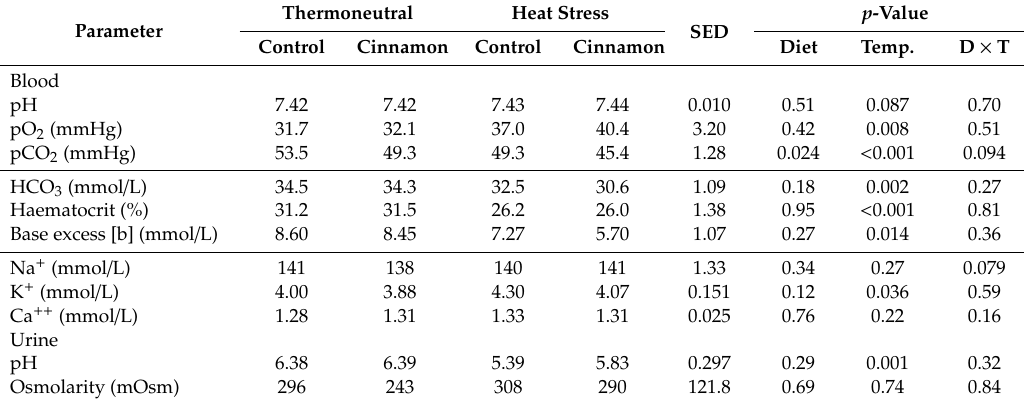
Table 4. The e ff ect of dietary cinnamon (control vs. 1.5%) and thermoneutral vs. heat stress conditions on transepithelial resistance (TER) and permeability (FITC) of the small intestine. Parameter